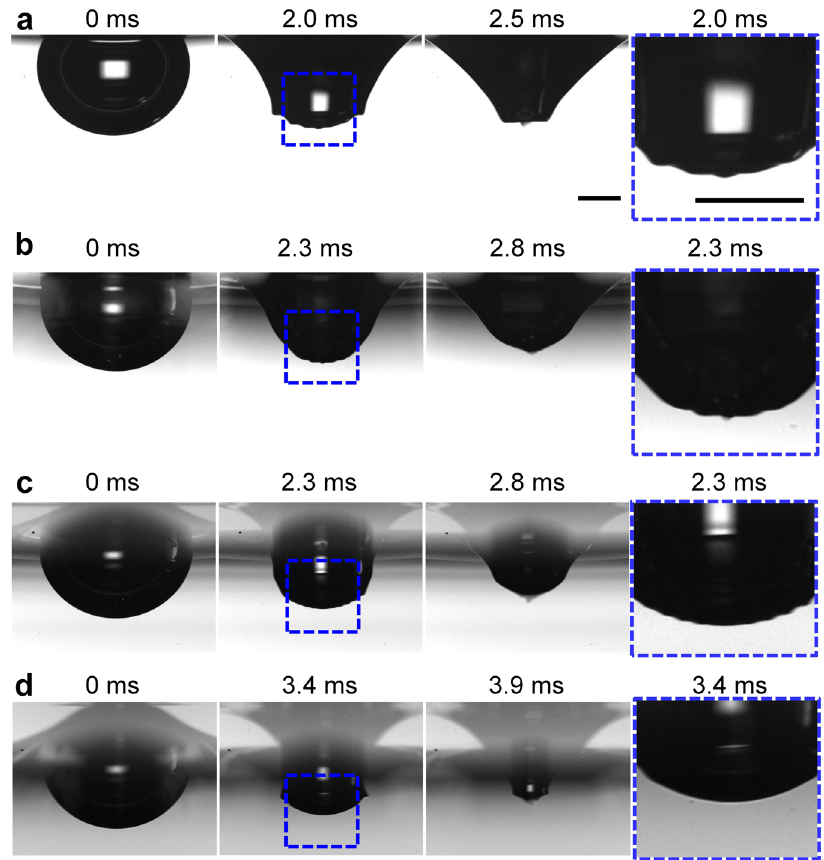
Fig. 4 Side-view snapshots of cavity collapse during bubble bursting. The water surfaces shown here are ( a ) clean, or covered by a layer of ( b ) 100 cSt silicone oil, h / R = 0.8, ( c ) 1000cSt silicone oil, h / R = 0.8, and ( d ) 1000 cSt silicone oil, h / R = 1.2. The equivalent bubble radius R = 1.67 mm in the experiments. Scale bars represent 1 mm. The capillary waves during cavity collapse are progressively damped in the oily cases compared with those in the pure water case (column 4 as the zoom-in images of the blue square zones in column 2), which results in a sharper tip at the cavity nadir in the oily cases (column 3), indicating the additional damping effect from the oil